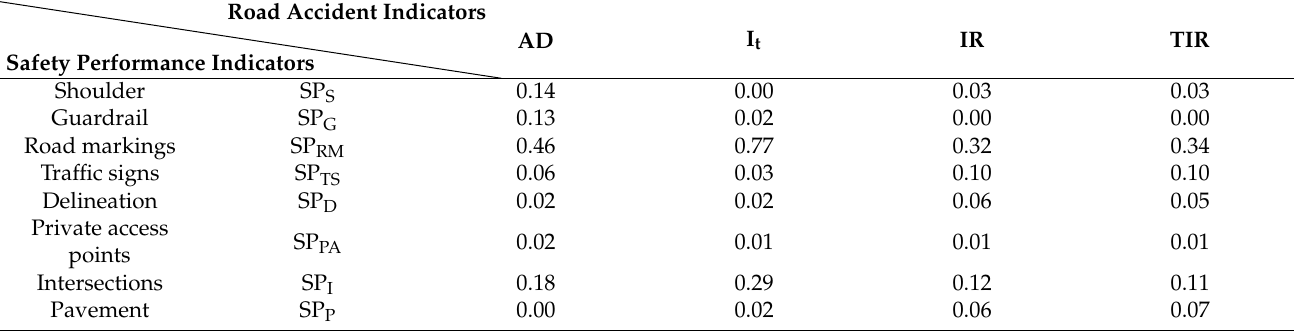
Table 5. R 2 values for the urban Table 4. R 2 values for the rural environment.